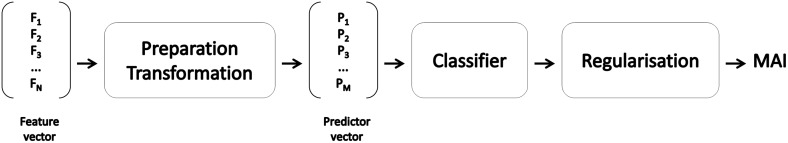
Overview of MAI algorithm steps.